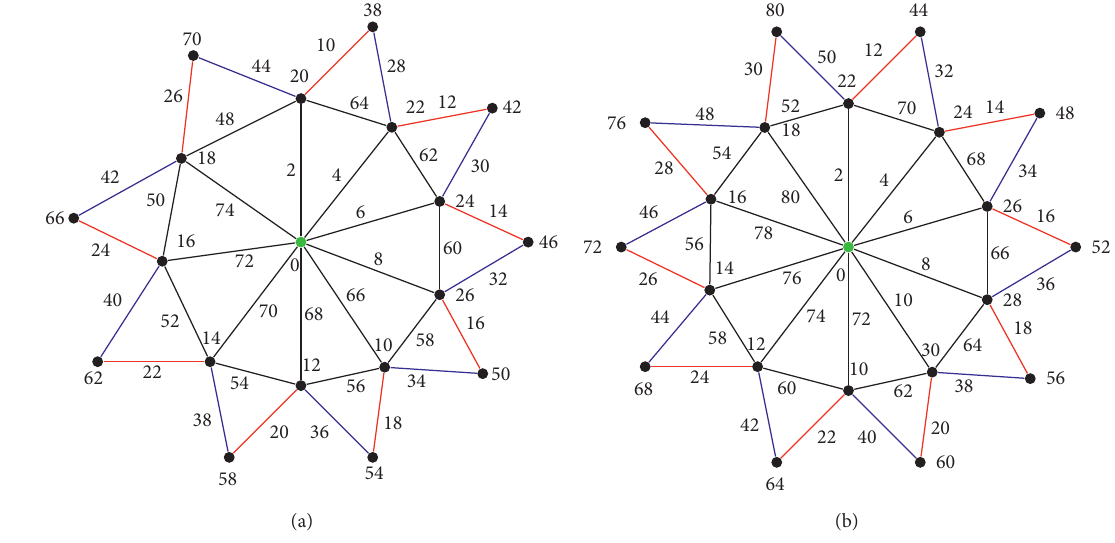
Figure 27: (a) 2-edge even graceful labeling of SF